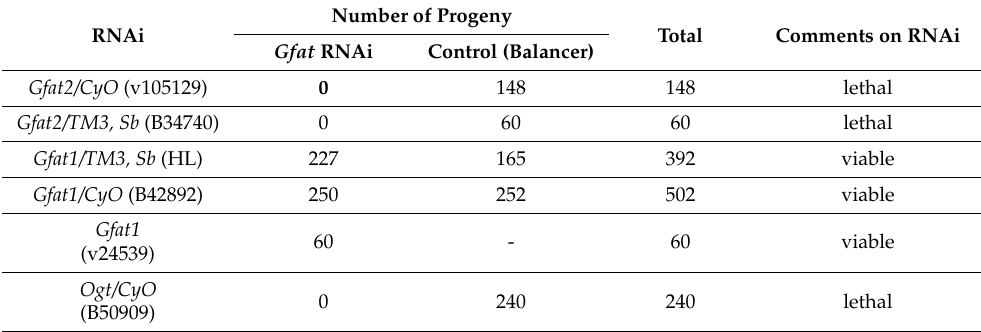
Table 4. Tests for viability effects of Gfat2 , Gfat1 , and Ogt knockdown in muscle cells at 29 ◦ C using Mef2-GAL4